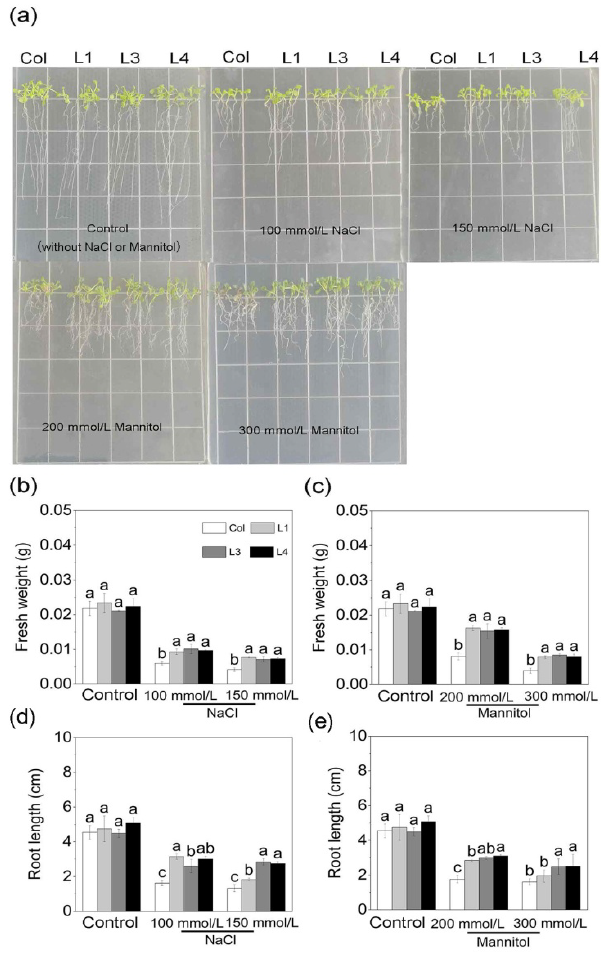
Fig. 3: Phenotypic analysis of seedlings of transgenic Arabidopsis lines and wild type under NaCl and mannitol treatment: (a) Phenotypes of transgenic lines and wild-type seedlings under NaCl and man- nitol treatment; (b-c) Fresh weight of transgenic lines and wild-type seedlings under NaCl and mannitol treatment; (d-e) Length of the main root of transgenic lines and wild-type seedlings under NaCl and mannitol treatment.